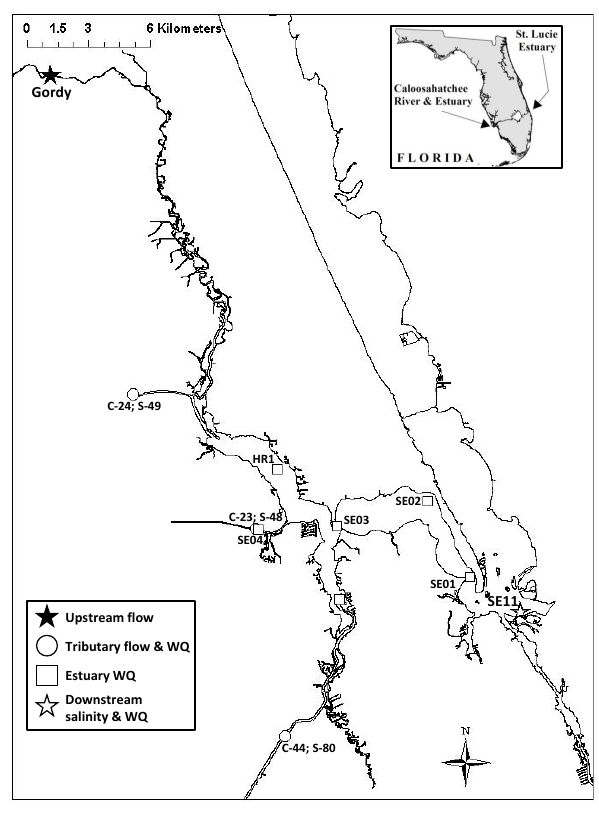
Fig. 2. Map depicting the St. Lucie Estuary. See Table 1 and Sect. 2.2 for details of data sources and integration into the nutrient budgets. Included is the upstream boundary for freshwater inflow (Gordy Rd.; filled star), three locations of tributary water quality and inflow data (open circles), six locations of estuary water qual- ity data (open squares), and the downstream boundary location for water quality and salinity (SE-11; open